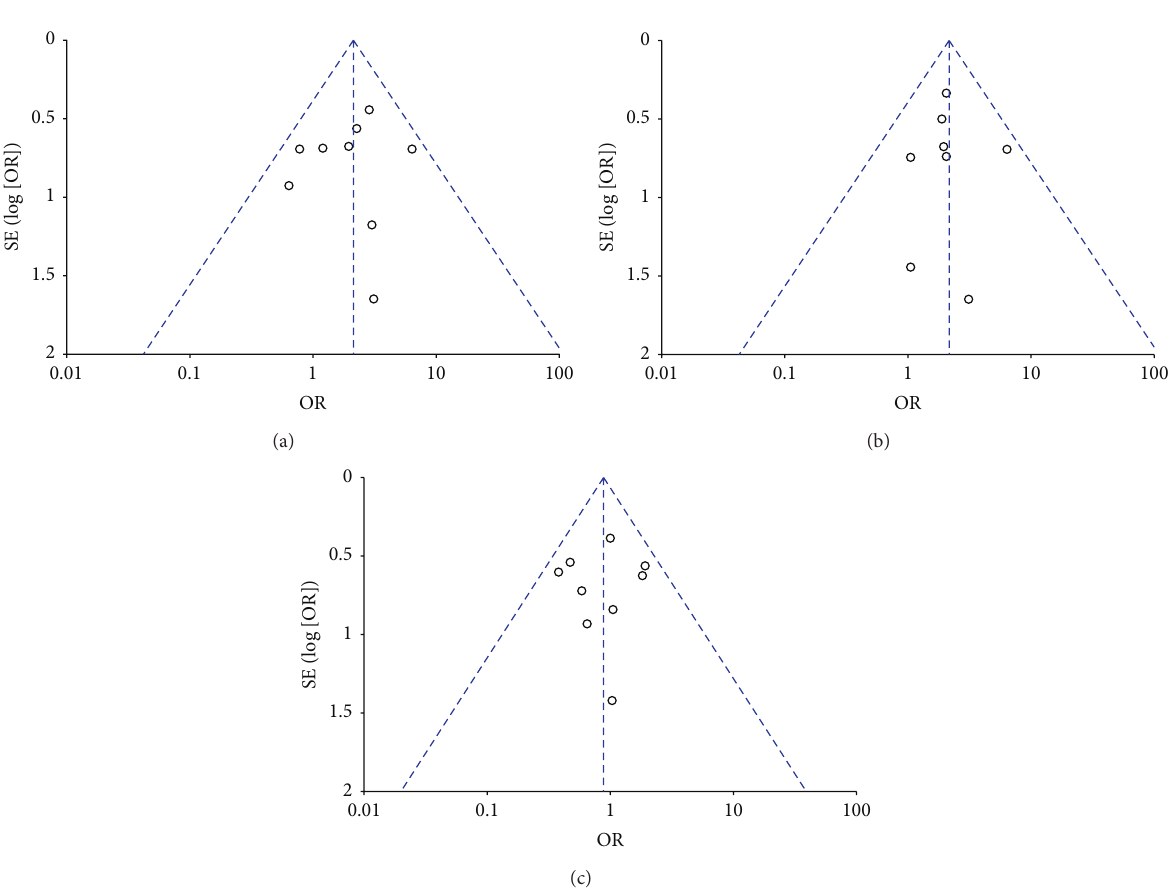
of mesna always had a wide 95% CI. Therefore,